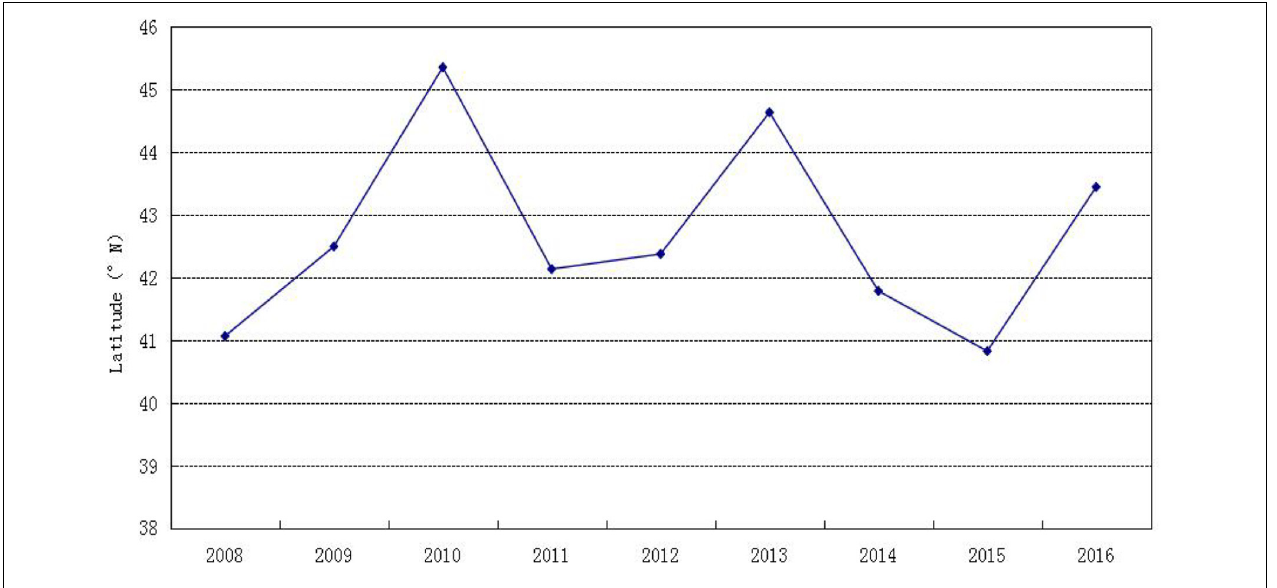
FIGURE 2 | The new East Asian summer monsoon index (NEWI) for 2008–2016.